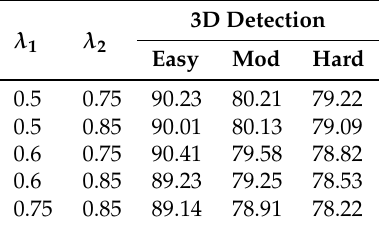
Table 2. Ablation study of setting of λ 1 and λ 2 of Algorithm 1. The results are reported on the KITTI validation set.